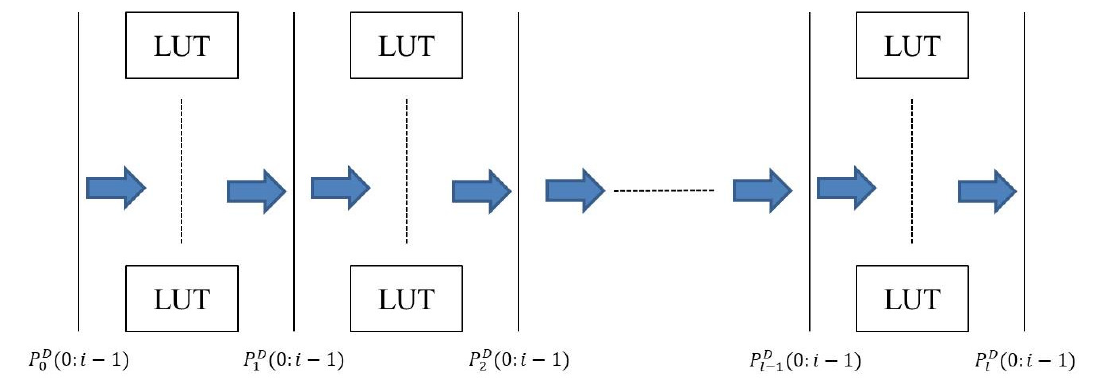
Figure 3. Structure of P D